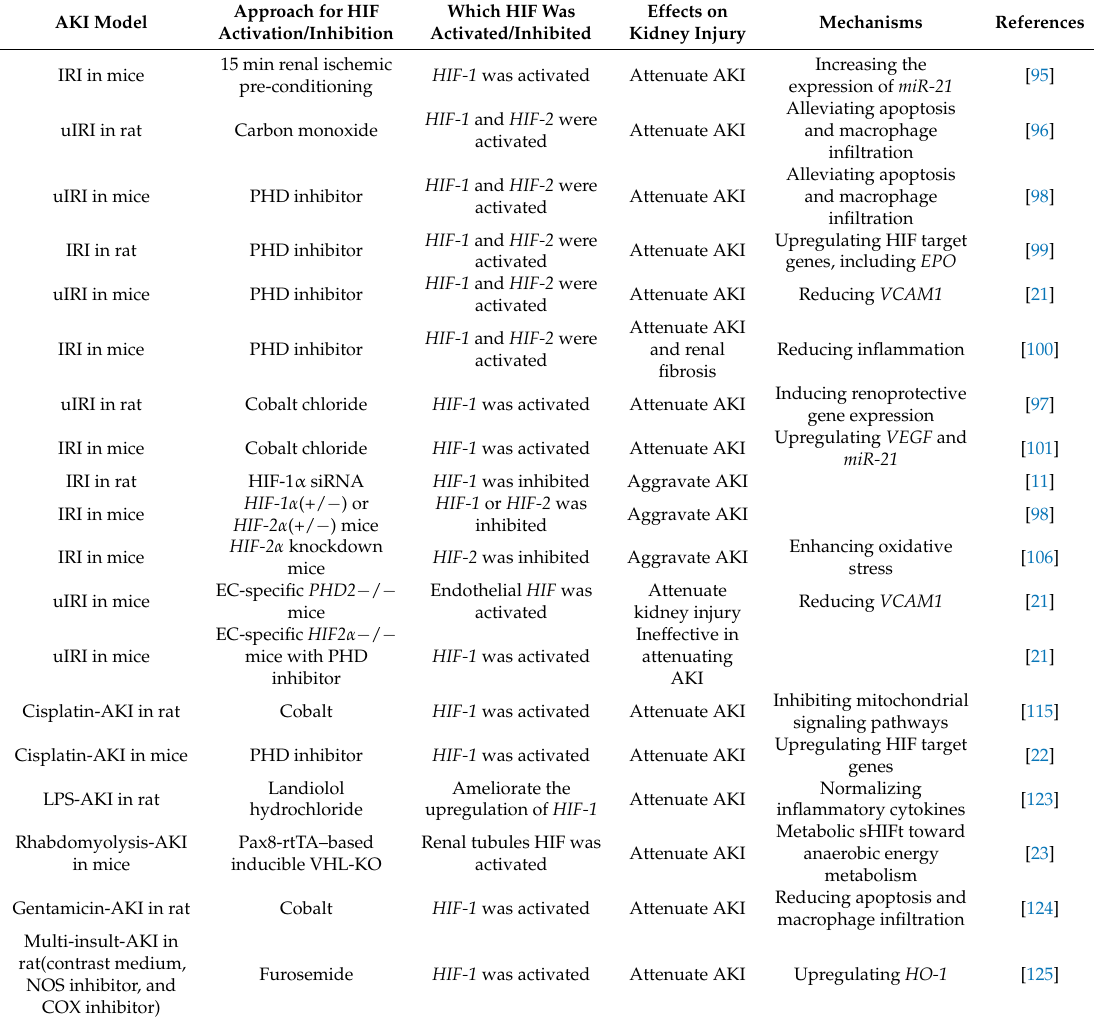
Table 1. Summary of in vivo studies on the effect of HIFs in kidney